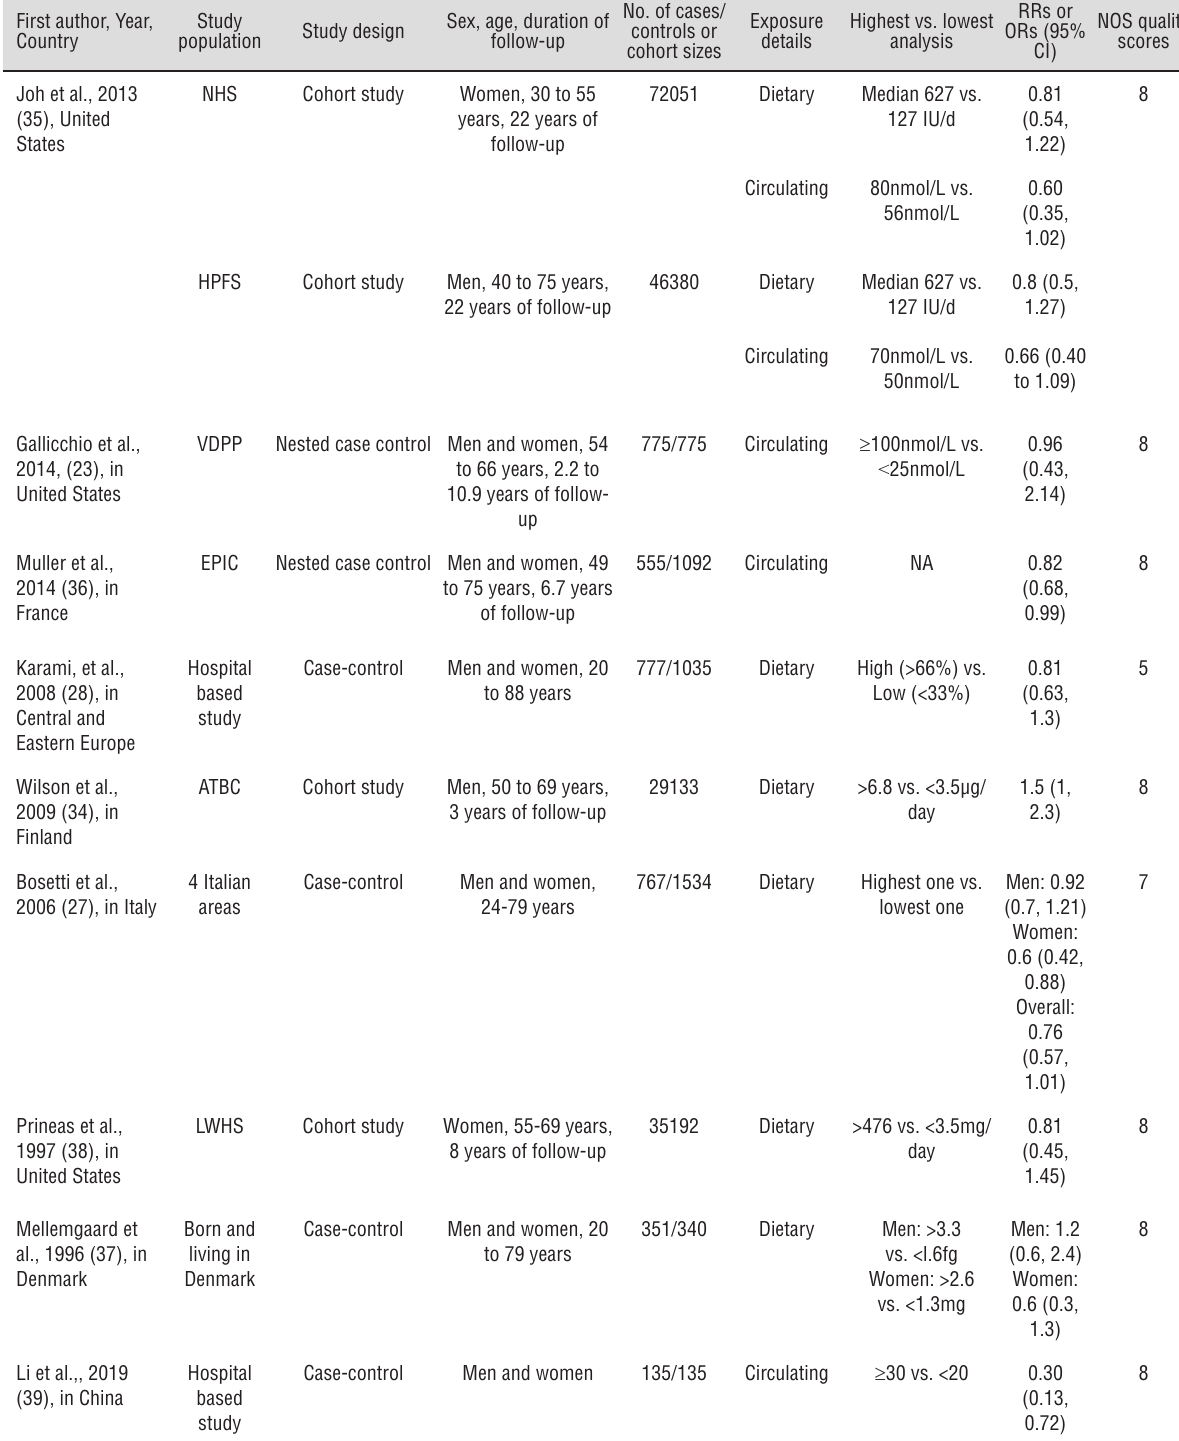
Table 1 - Characteristics of included studies in